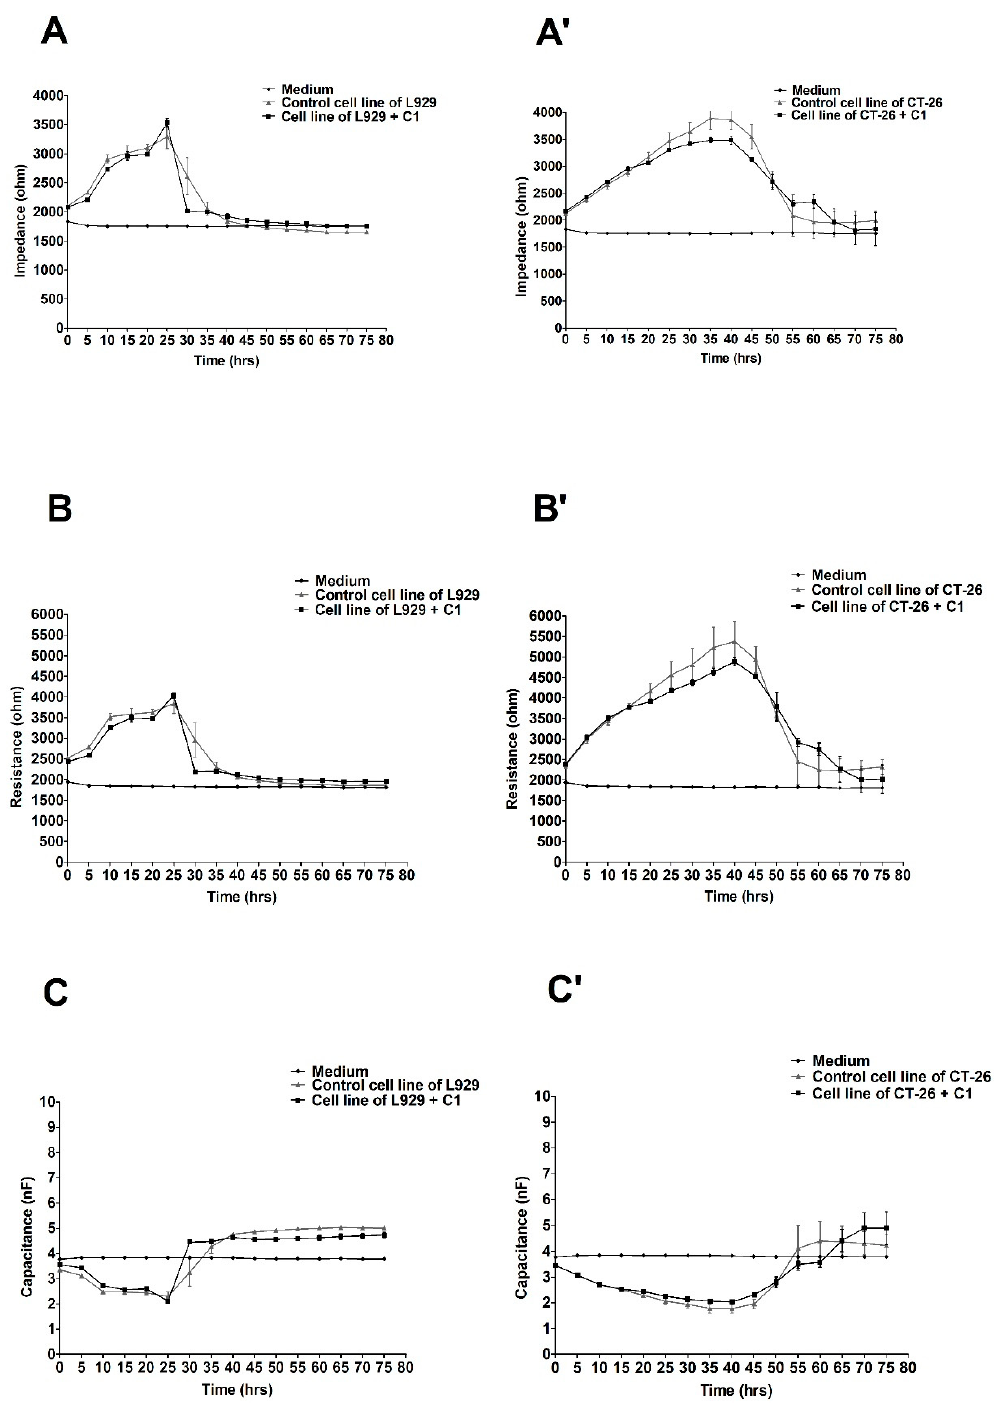
Figure 1. Impedance, resistance, and capacitance monitoring of the cell lines L929 ( A – C ) and CT-26 ( A’ – C’ ) during 80 h treatment with ex-LMS in concentration C1. The graphs show the course of impedance changes in L929 ( A ) and CT-26 ( A’ ) cultures after treatment with ex-LMS at a concentration of C1 (2.28 µ g/mL); resistance changes in L929 ( B ) and CT-26 ( B’ ) cultures after treatment with ex-LMS at a concentration of C1 (2.28 µ g/mL); and capacitance changes in L929 ( C ) and CT-26 ( C’ ) cultures after treatment with ex-LMS at a concentration of C1 (2.28 μ g/mL). Data are presented as mean value ± SEM.